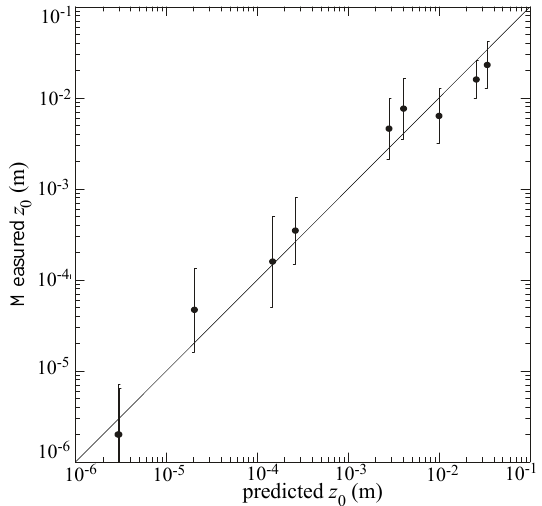
Figure 13. Plot of mean measured z 0 values vs. predicted values (using Eq. 4) for the 10 study sites. Error bars denote 1 σ variations in the measured z 0